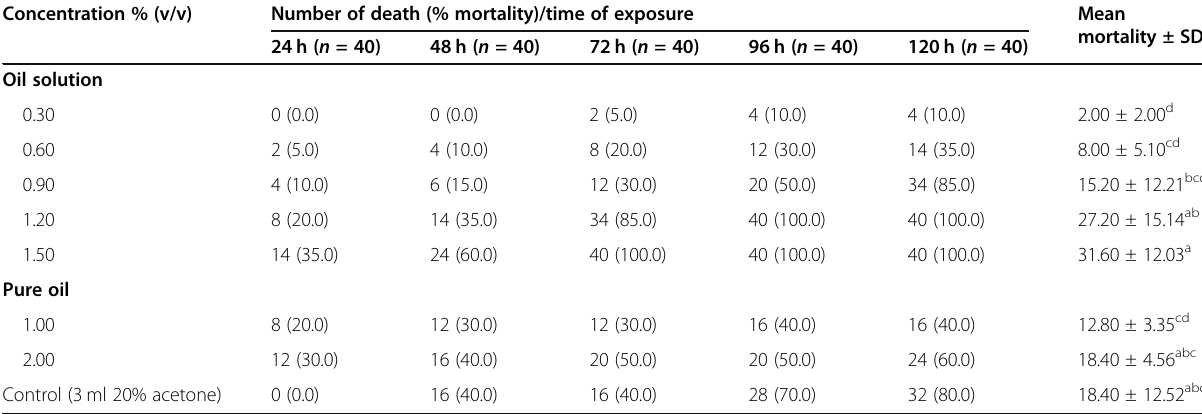
Table 2 Percentage mortality of P. americana on exposure to J. curcas pure oil (contact toxicity) Concentration % (v/v) Number of death (% mortality)/time of